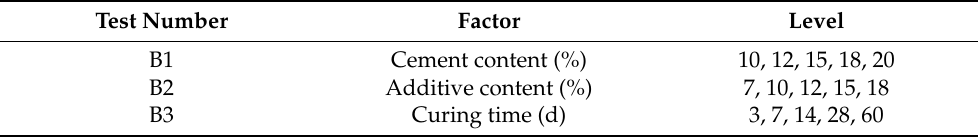
Table 7. Test scheme for compressive strength properties of RCELP solidified soil. Test